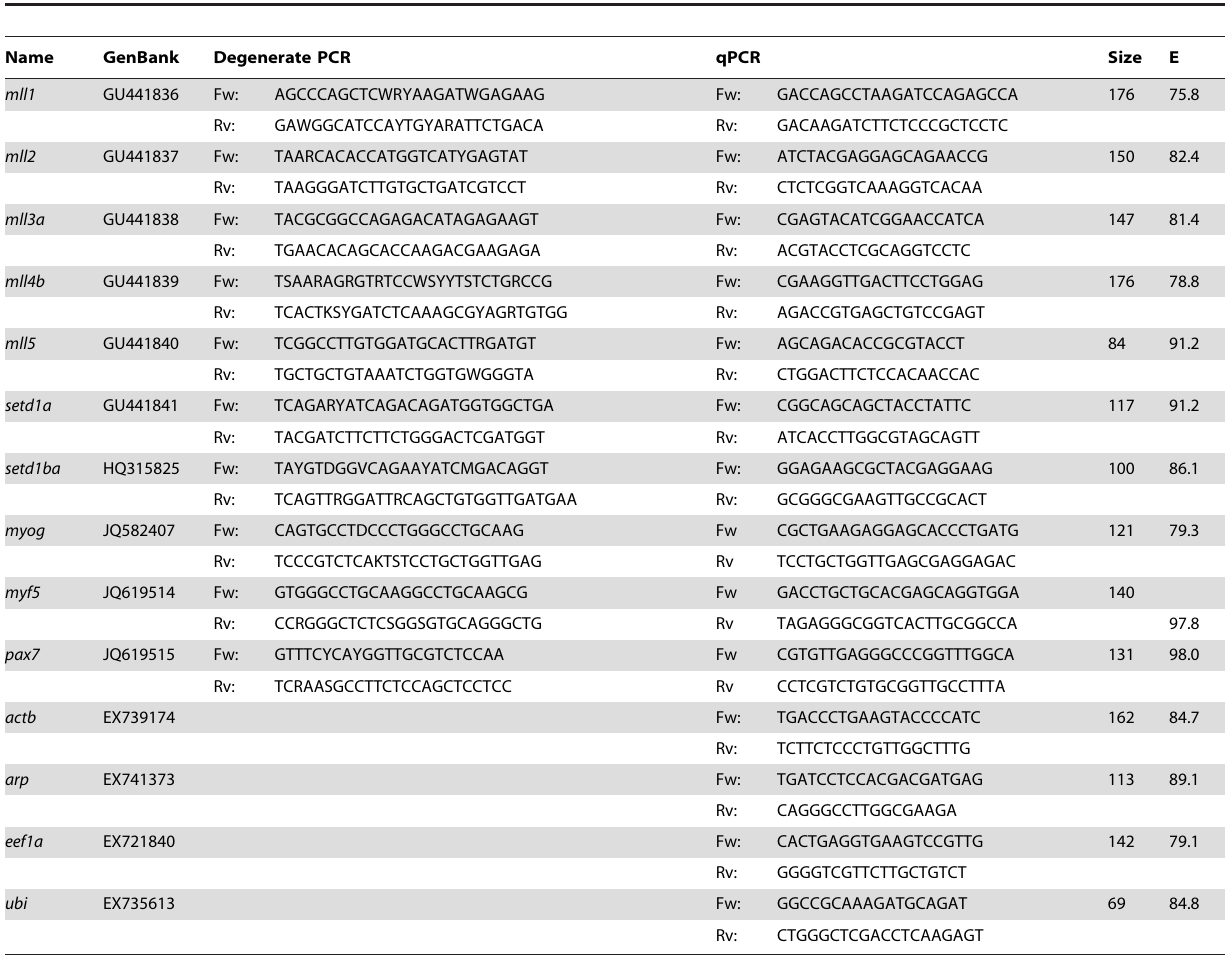
Table 1. Gene name, GenBank accession number, primer sequences (5 9 to 3 9 ), amplicon sizes (bp) and PCR efficiency (%) of mll, s et1d and myogenic genes cloned in Atlantic cod.